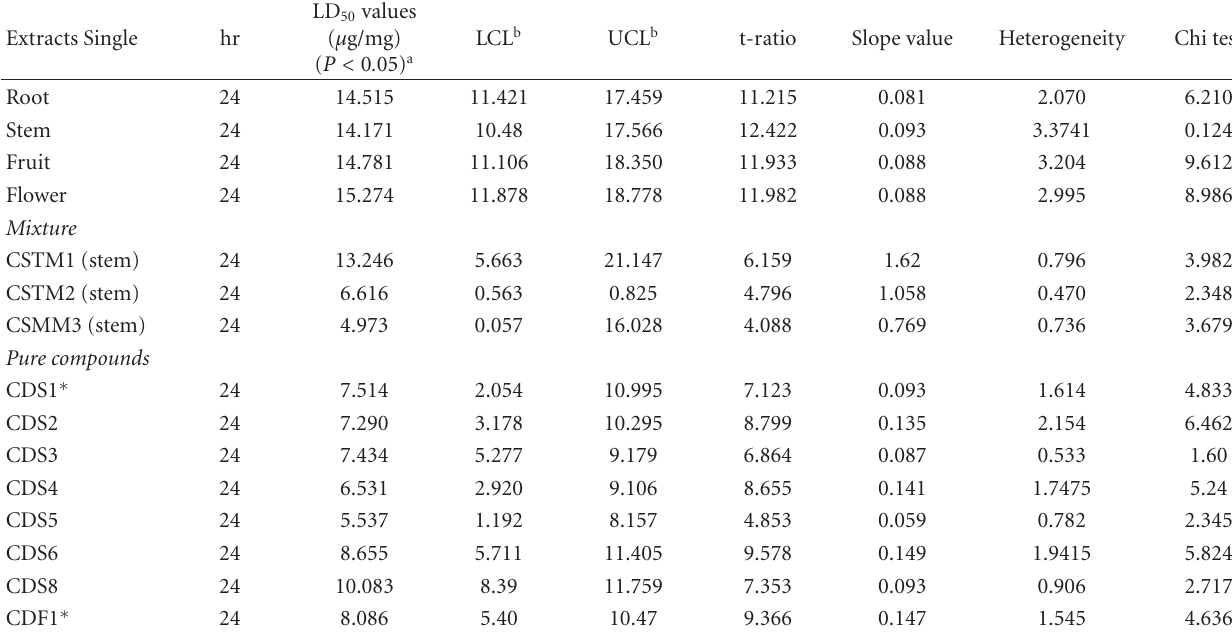
Table 1: LD 50 values obtained in solvent extracts and pure compounds isolated from Capparis decidua against Indian white termite Odontotermes